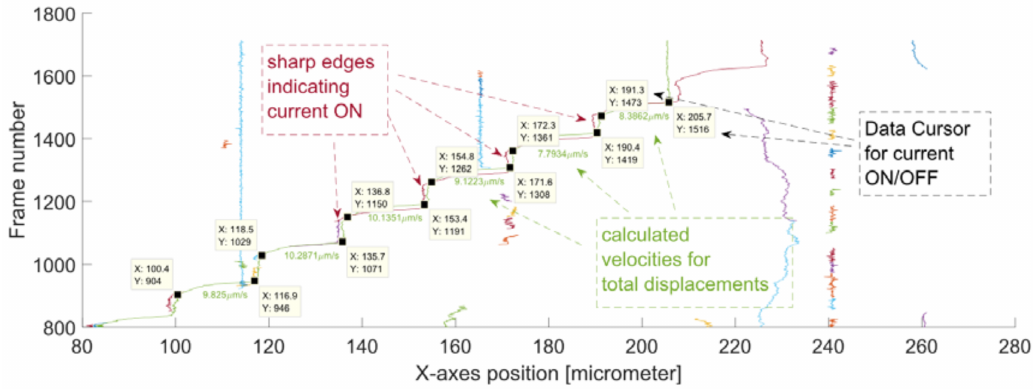
Figure 9. The displacement of the tracked MPs over a sequence of frames without any E. coli attached to their surface. There are two characteristic manipulation paths for: MP nr . 103 (green) and MP Nr. 105 (dark